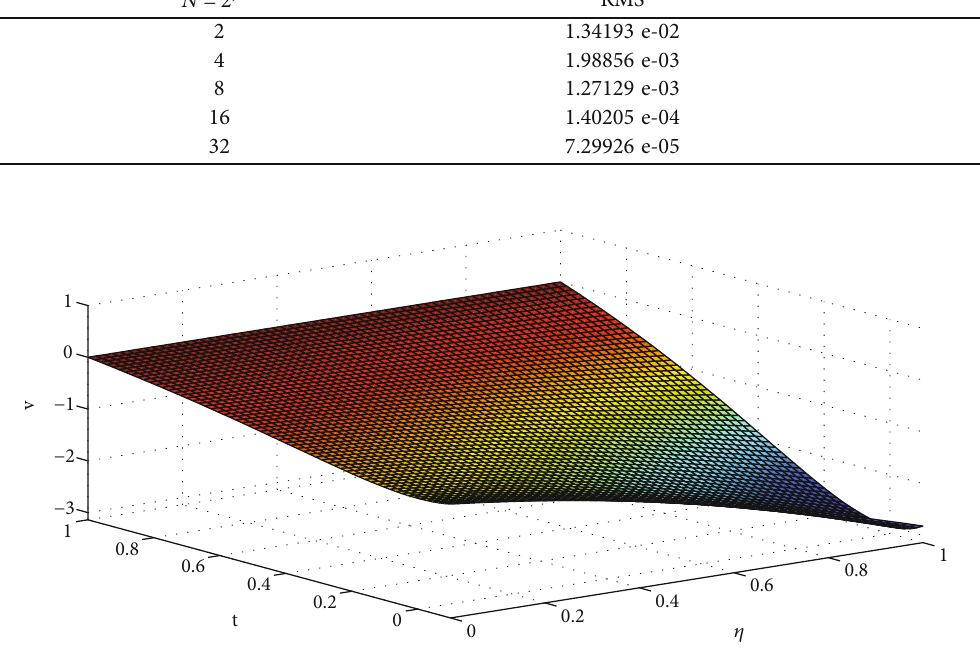
Figure 4: Surface plot of approximate solution of Example 4 at N = 32